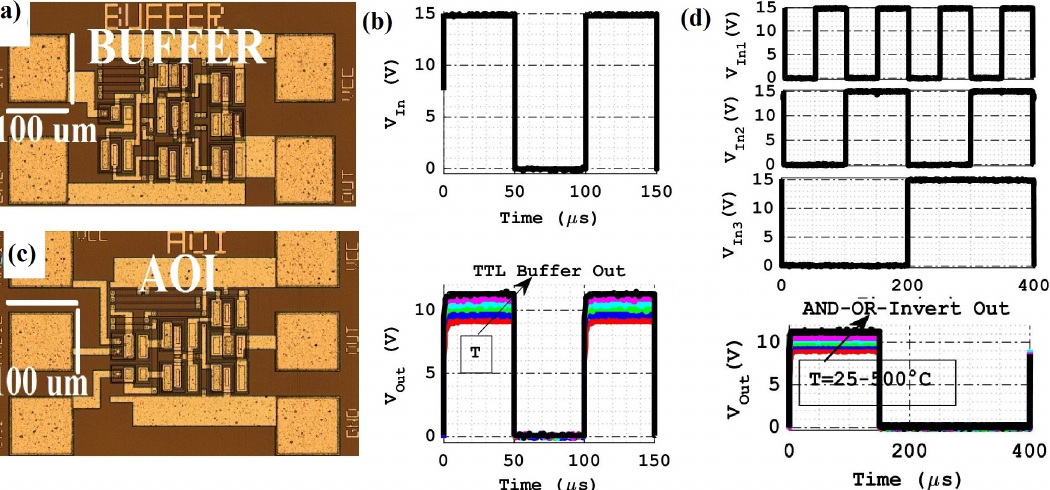
Figure 14. SiC TTL Buffer and AOI circuits micro-photograph with measured transient-response in the range of 25 to 500 ○ C by applying f in 1 = 10 kHz, f in 2 = 5 kHz and f in 3 = 2.5 kHz, with V IH = 15 V and V IL = 0 V ( a ) TTL Buffer micro-photograph ( b ) Buffer measured transient-response ( c ) TTL AOI micro-photograph ( d ) AOI measured